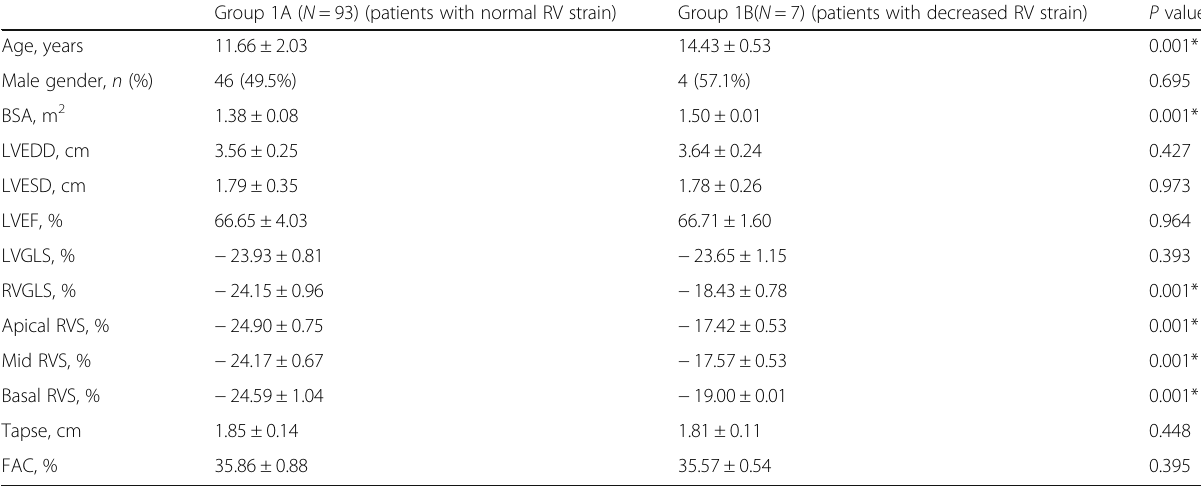
Table 3 Basal characteristics, echocardiographic results, and RV 2DSTE of group 1 subgroups at 10 weeks of receiving chemotherapy Group 1A ( N = 93) (patients with normal RV strain) Group 1B( N = 7) (patients with decreased RV strain)